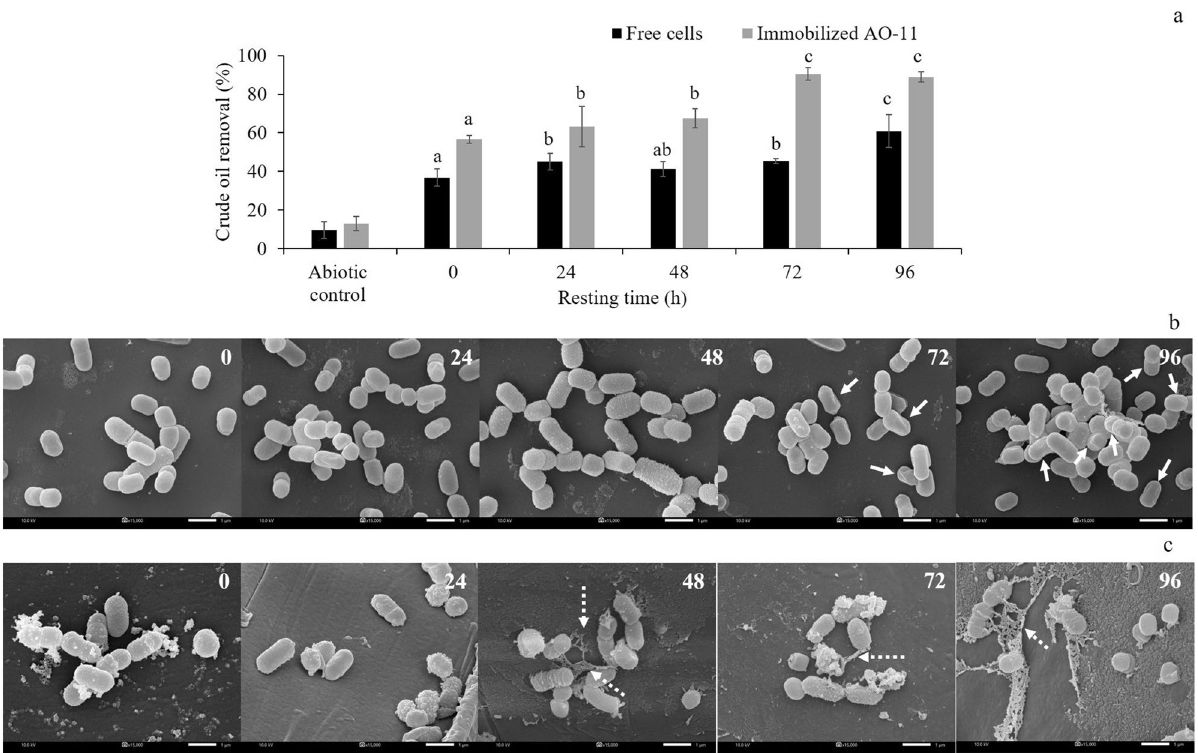
Figure 3. Crude oil removal of free cells and immobilized Exiguobacterium sp. AO-11 after starvation for 0, 24, 48, 72 and 96 h in MNSW containing 0.25% (v/v) crude oil incubated at room temperature for 9 days ( a ). SEM micrographs of free cells ( b ) and immobilized AO-11 cells on bio-cord ( c ) after starvation arranged from left to right of the pictures (15,000 ×): 0 h; 24 h; 48 h; 72 h; and 96 h. The white arrows indicate morphological changes and the accumulation of free cells at 72–96 h. The white dashed arrows indicate biofilm produced by Exiguobacterium sp. AO-11. Data correspond to the means of triplicate values, and error bars correspond to the standard deviation.